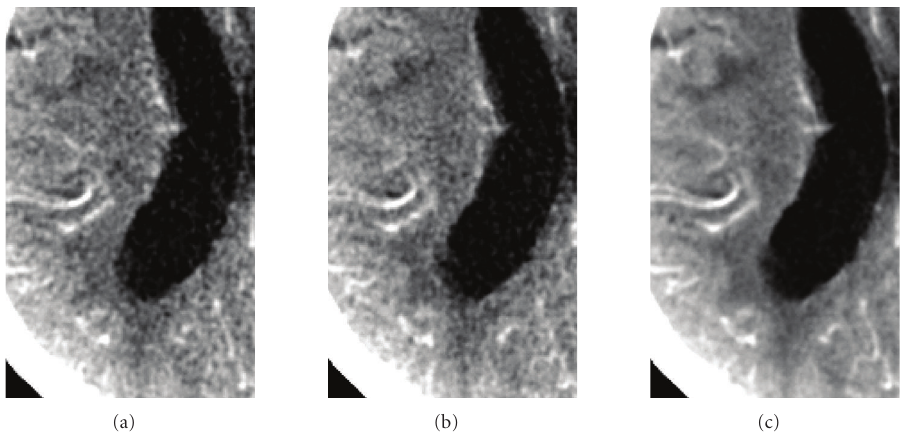
Figure 10: Detail of the left hemisphere in a frame of the perfusion sequence with high contrast enhancement ( t = 19 s). (a) Original sequence. (b) Sequence 4 ( T s = 4 s). (c) Sequence 1 ( T s = 1 s). Window [16,56]